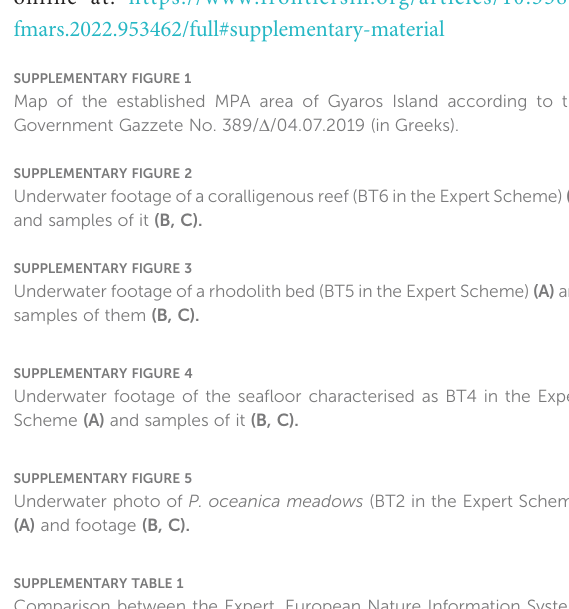
SUPPLEMENTARY FIGURE 2 Underwaterfootageofacoralligenous reef(BT6intheExpertScheme) (A) and samples of it (B,